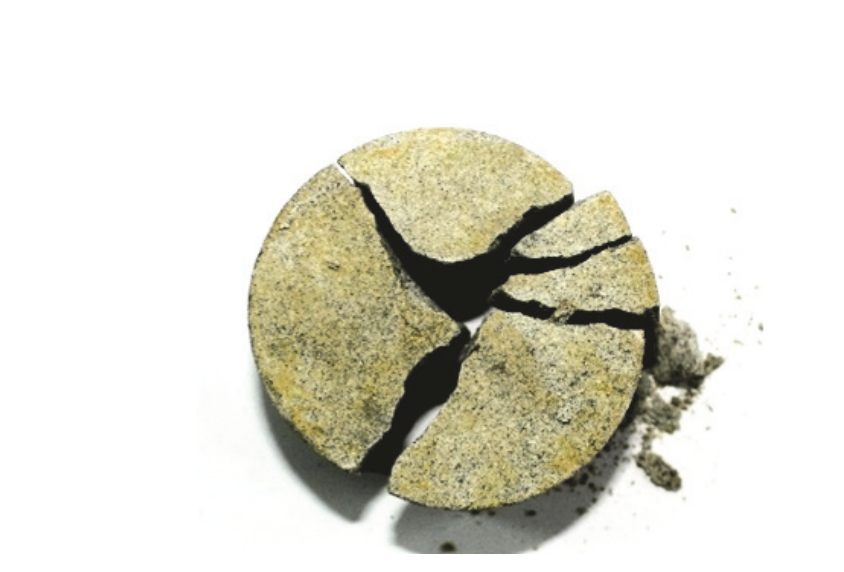
Figure 15: Failure modes of specimens in the SHPB test (the length-diameter ratio of specimen is 0.5, and the average strain rate is 75.3 s −1